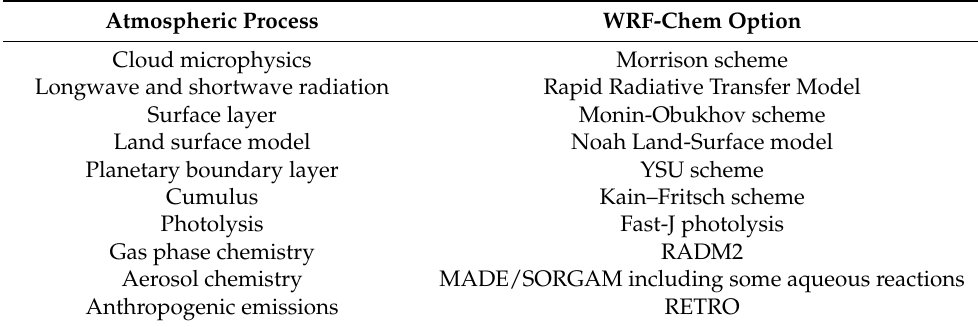
Figure 1. The simulated region (60° W–150° E, 5° S–45° N). Table 1. WRF-Chem configuration options for the experiment. YSU, Yonsei University; RADM2, Regional Acid Deposition Model version 2.